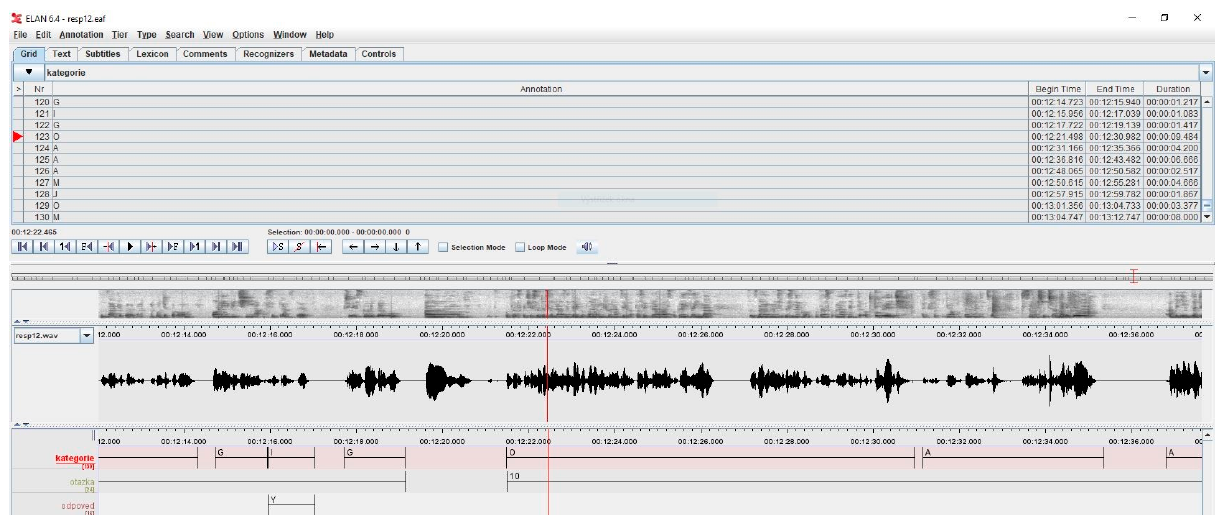
Figure 6. ELAN annotation environment.